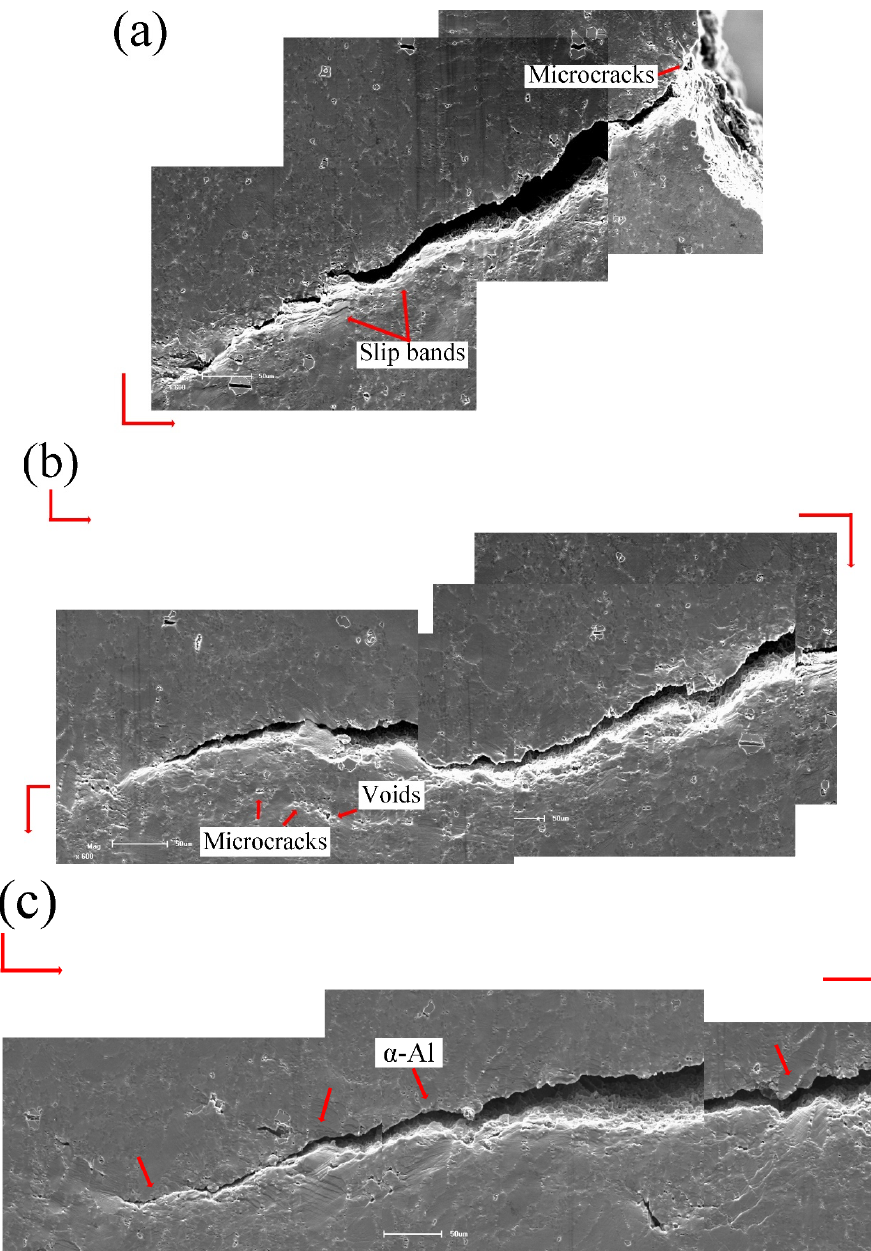
Figure 9. Crack propagation during in-situ tensile testing of the T6-treated AlSiMgMn alloys, showing ( a ) microcracks initiation at small subsurface pores, ( b ) voids initiation, ( c ) final crack path.